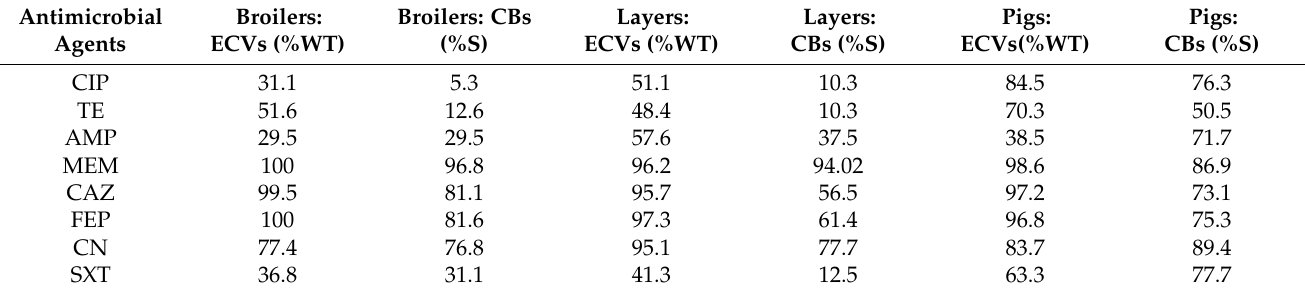
Table 5. Comparison of ECVs and CLSI clinical breakpoints of antibiotics tested against E. coli isolated from poultry and pigs.